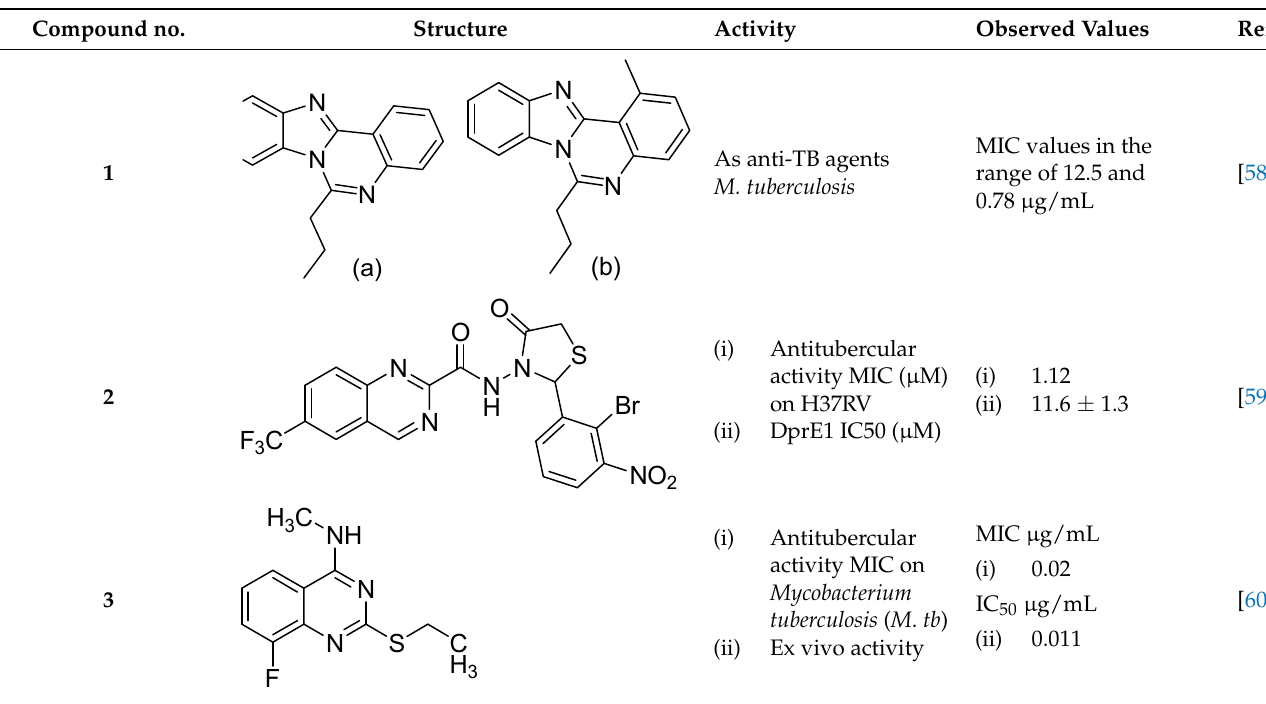
Table 5. Antitubercular activity of quinazoline derivatives.